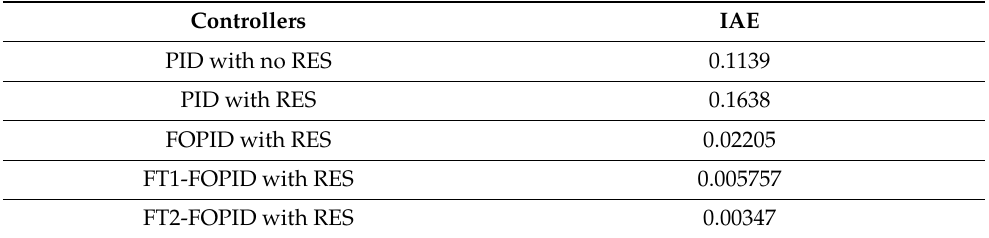
Table 6. IAE results obtained for various controllers for demand change of 1% in Area 1 and 2% in Area